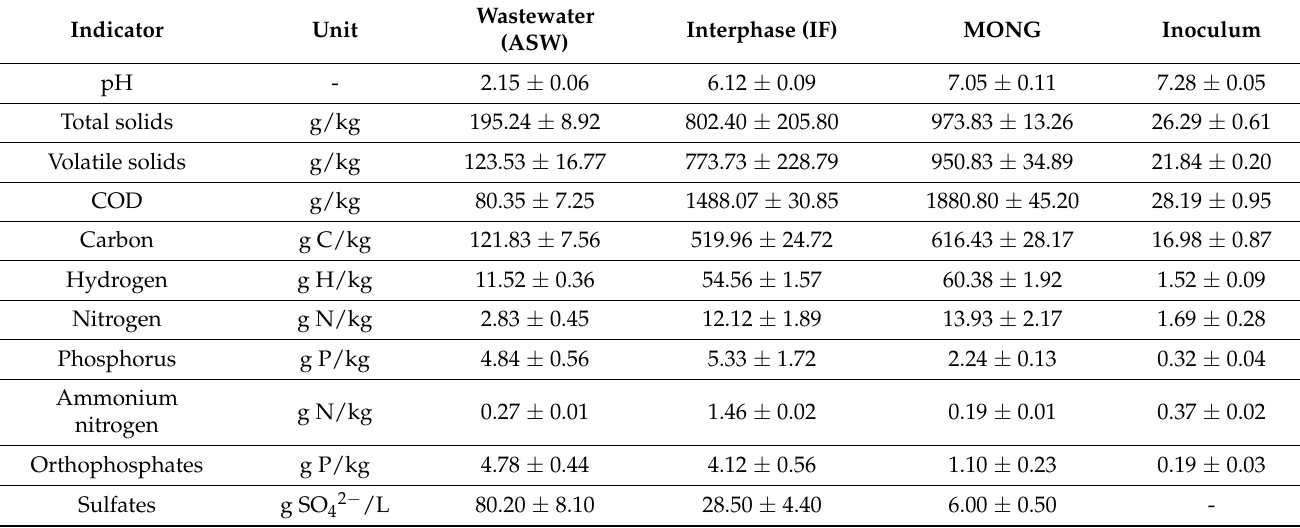
Table 1. Characteristics of fresh materials and inoculum used for the